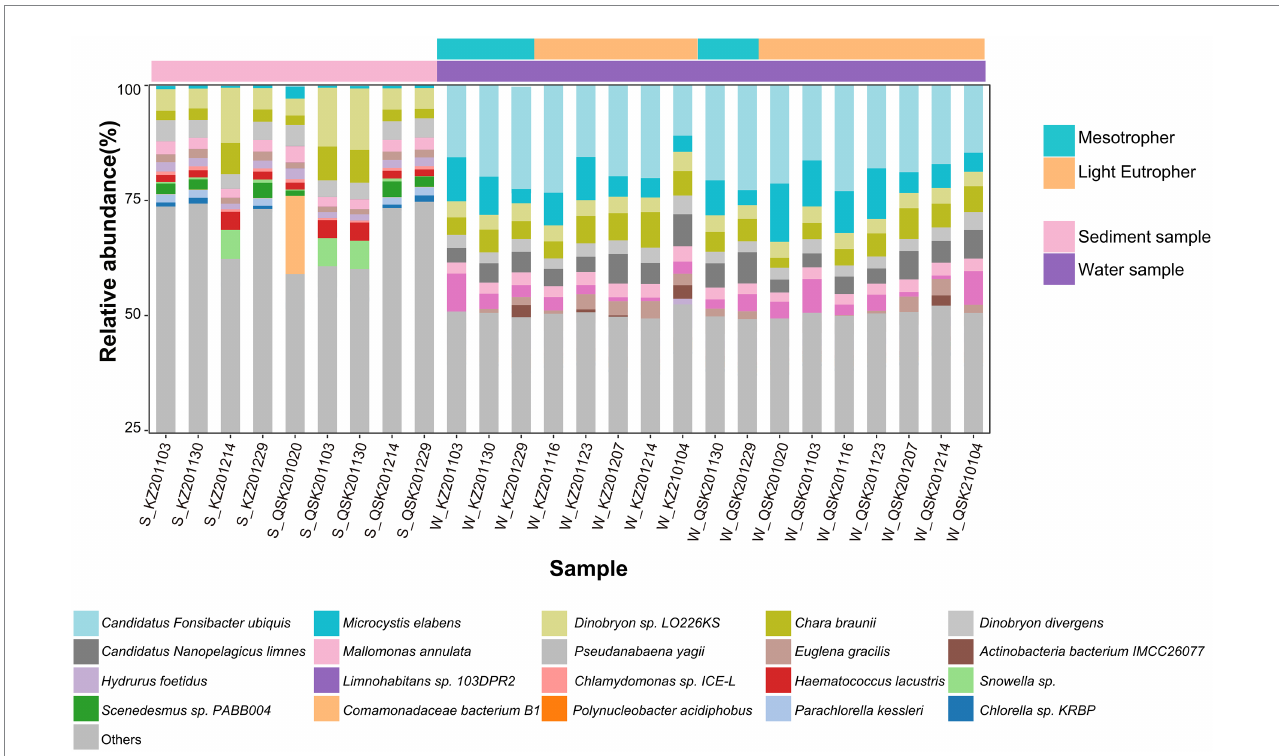
FIGURE 2 Histogram of relative abundances at the species level. The 20 most abundant species are shown, and “Other” indicates species with relative abundances less than 0.6% across all